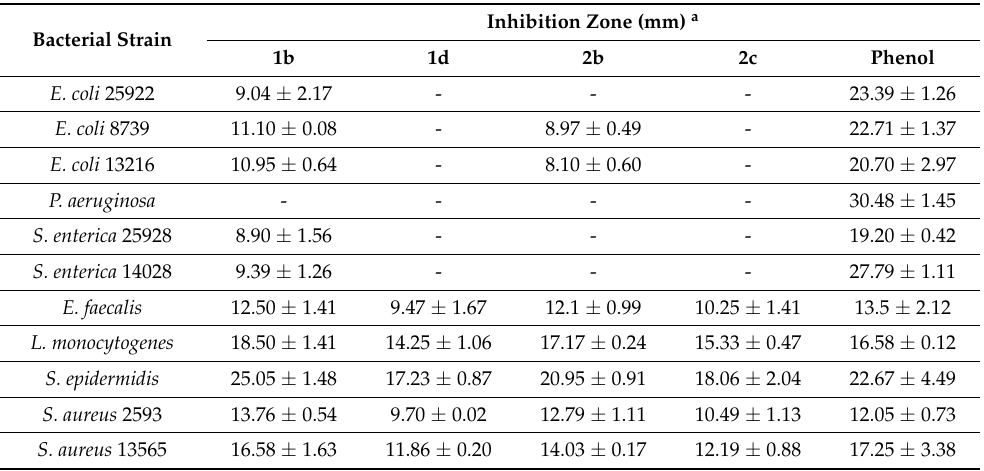
Table 1. Analysis of the antibacterial effect of complexes [Au(L2b)(IMe)] ( 1b ), [Au(L2d)(IMe)] ( 1d ), [Au(L2b)(IPr)] ( 2b ) y [Au(L2c)(IPr)] ( 2c ) (5 µ g) upon 24 h incubation. Phenol (5.35 mg) was used as positive control.